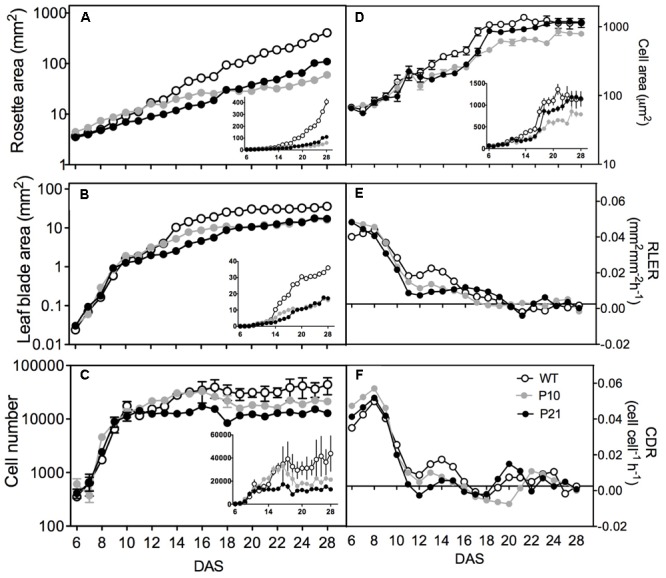
Kinematic growth analysis of the first leaf pair of Arabidopsis wild type and PID overexpression lines. Rosette area, n = 40–50 (A). Leaf blade area, n = 24–26 (B). Average cell number in a leaf, n = 6 (C). Average cell area, n = 6 (D). Relative leaf expansion rate (E). Cell division rates (F). Insets show the same on a linear scale. Error bars represent averages ± SE of two replicate experiments.